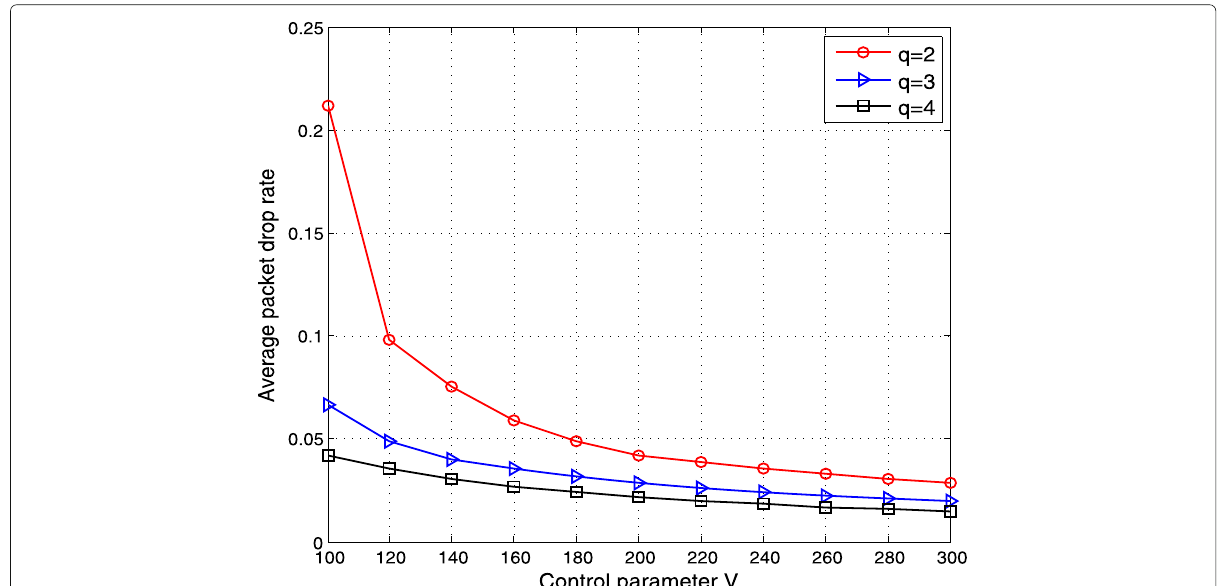
Fig. 6 The average packet drop rate versus the control parameter V with different